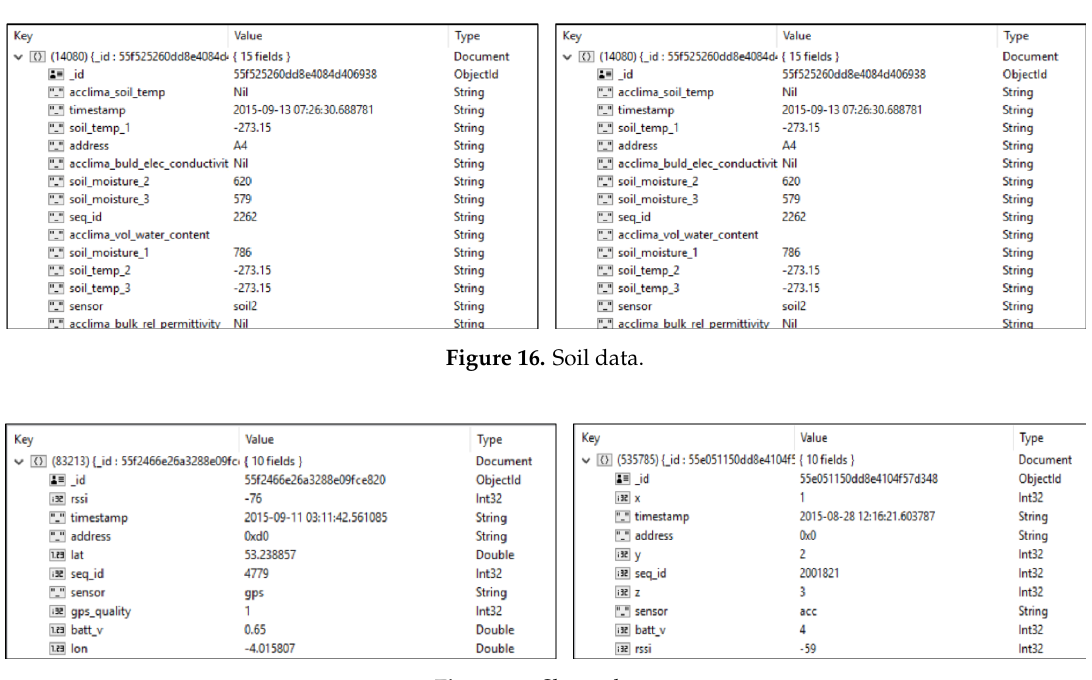
Figure 17. Sheep data.